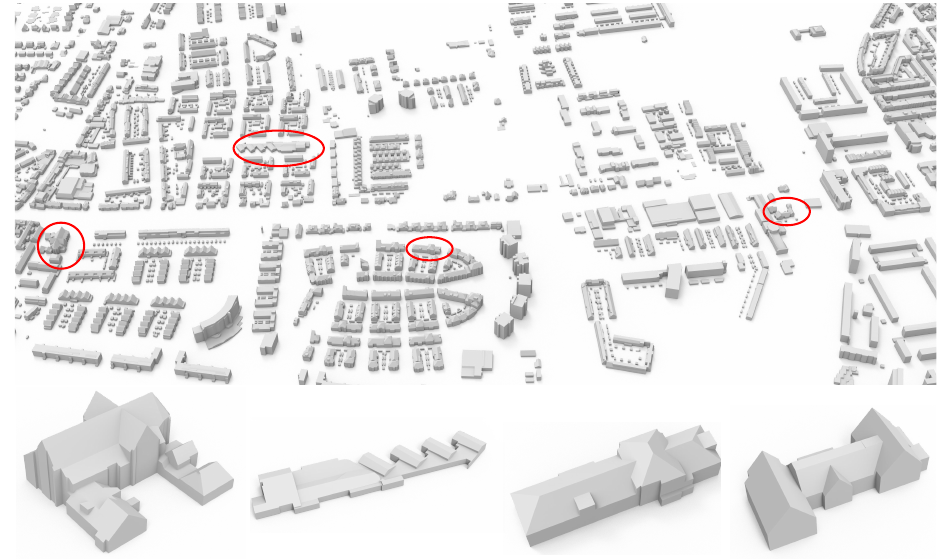
Figure 5. Reconstruction of a large scene from the AHN3 dataset [21].